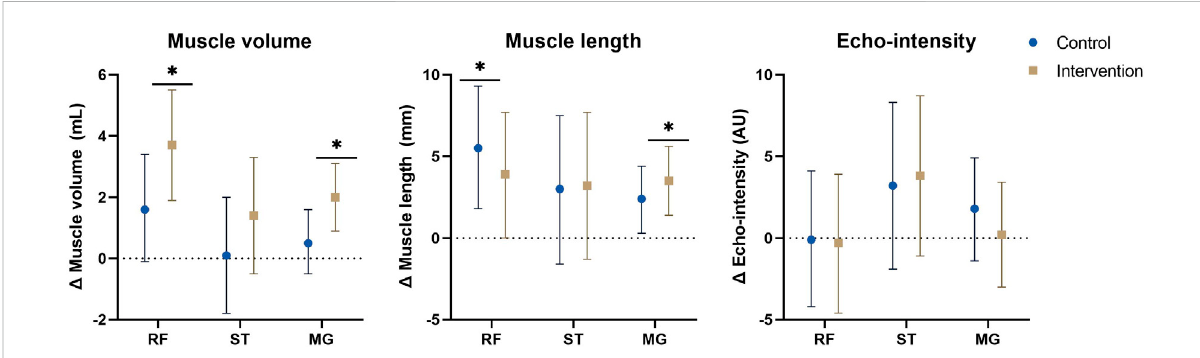
FIGURE 2 Estimated marginal mean differences with 95% con fi dence interval of mixedmodel analyses for muscle morphology with results for within and between analyses including all participants and all affected legs. *: signi fi cant time-effect at p ≤ 0.01. Abbreviations: Δ , change; MG, medial gastrocnemius; RF, rectus femoris; ST, semitendinosus. Units: AU, arbitrary units; mL, milliliter; mm,